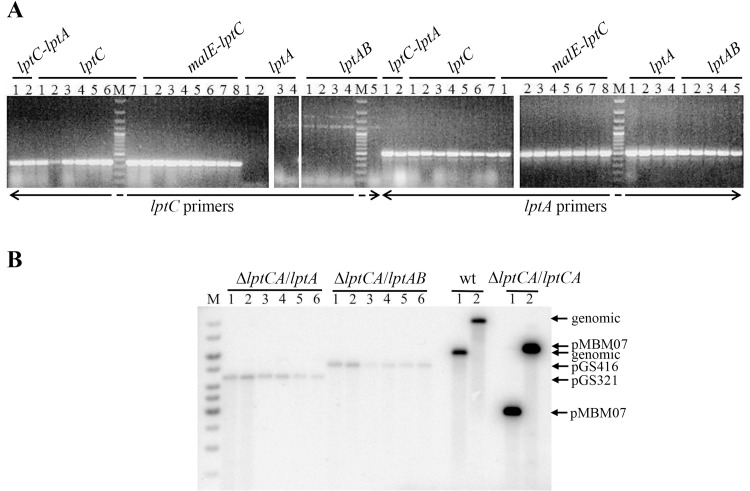
Screening for the presence of lptA and lptC in plasmid shuffled clones by PCR and Southern blotting analysis.A. Electrophoretic analysis of PCR amplicons obtained with lptC- and lptA-specific pairs of primers (FG2760- FG2761 and FG2762- FG2763, respectively), as indicated on the bottom of the panel, from plasmid shuffled and control strains. On top of the lanes the lpt genes harbored by the plasmid used for transformation of the parental KG-286.05/pMBM07 are indicated: lptC-lptA, lanes 1–2, pGS404; lptC, lanes 1–7, pGS402; malE-lptC, lanes 1–8, pGS420; lptA, lanes 1–4, pGS321; lptAB, lanes 1–5, pGS416; M, molecular weight markers (100 bp ladder). See text for details. B. Southern blotting of DNA from plasmid shuffled transformant clones. Total DNA from clones obtained by shuffling with the plasmid indicated on top of the panel was digested with SalI (odd lane numbers) or HindIII (even lane numbers), Southern blotted and hybridized with a radioactive DNA probe obtained with primers FG3129-FG3130 and covering lptC nucleotides 4–532. ΔlptCA/lptA, lanes 1–6, six purified KG-286/pGS321 clones; ΔlptCA/lptAB, lanes 1–6, six purified KG-286/pGS416 clones; wt, lanes 1–2, AM604; ΔlptCA/lptCA, lanes 1–2, parental strain KG-286.05/pMBM07; M, molecular weight markers (1 kb ladder). The bands in lanes M, ΔlptCA/lptA 1–6, and ΔlptCA/lptAB 1–6 are due to non-specific hybridization of the probe with the DNA marker (M) and with the chasing plasmids (pGS321 and pGS416), both of which were linearized by SalI and HindIII digestions.